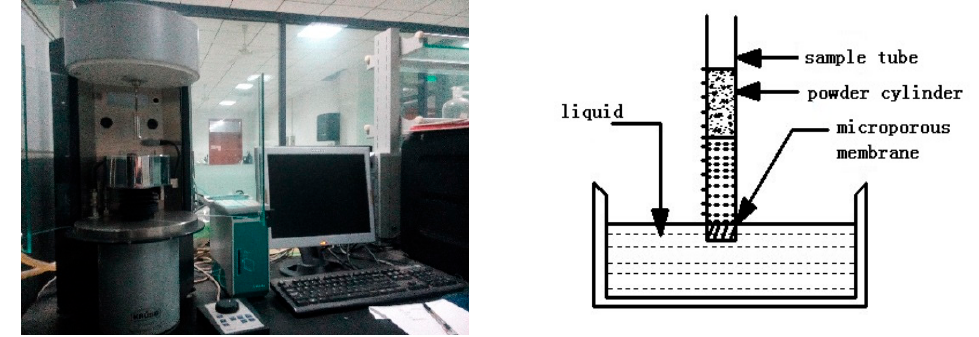
Figure 4. K100 Force Tensiometer (left) and diagram of liquid wetting powder